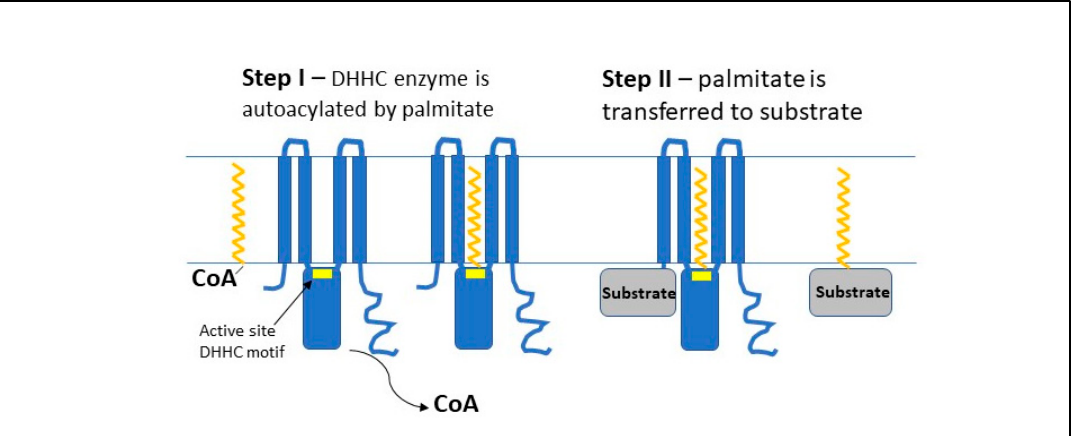
Figure 1. Proposed mechanism for palmitoylation catalyzed by DHHC enzymes. Step I is an autoacylation step, in which palmitate is transferred from palmitoyl–CoA thioester to the active site cysteine within the DHHC motif conserved among all DHHC enzymes [7–9]. Based on structural data obtained for hDHHC20 and zfDHHC15 [12], the DHHC motif (yellow block within the blue enzyme) is located at the membrane–cytoplasmic interface, and the attached palmitate transiently resides within the membrane lipid bilayer in a cavity formed by four canonical DHHC transmembrane domains. Step II involves transfer of palmitate from the DHHC–thioester directly to a membrane-proximal cysteine of a substrate protein.